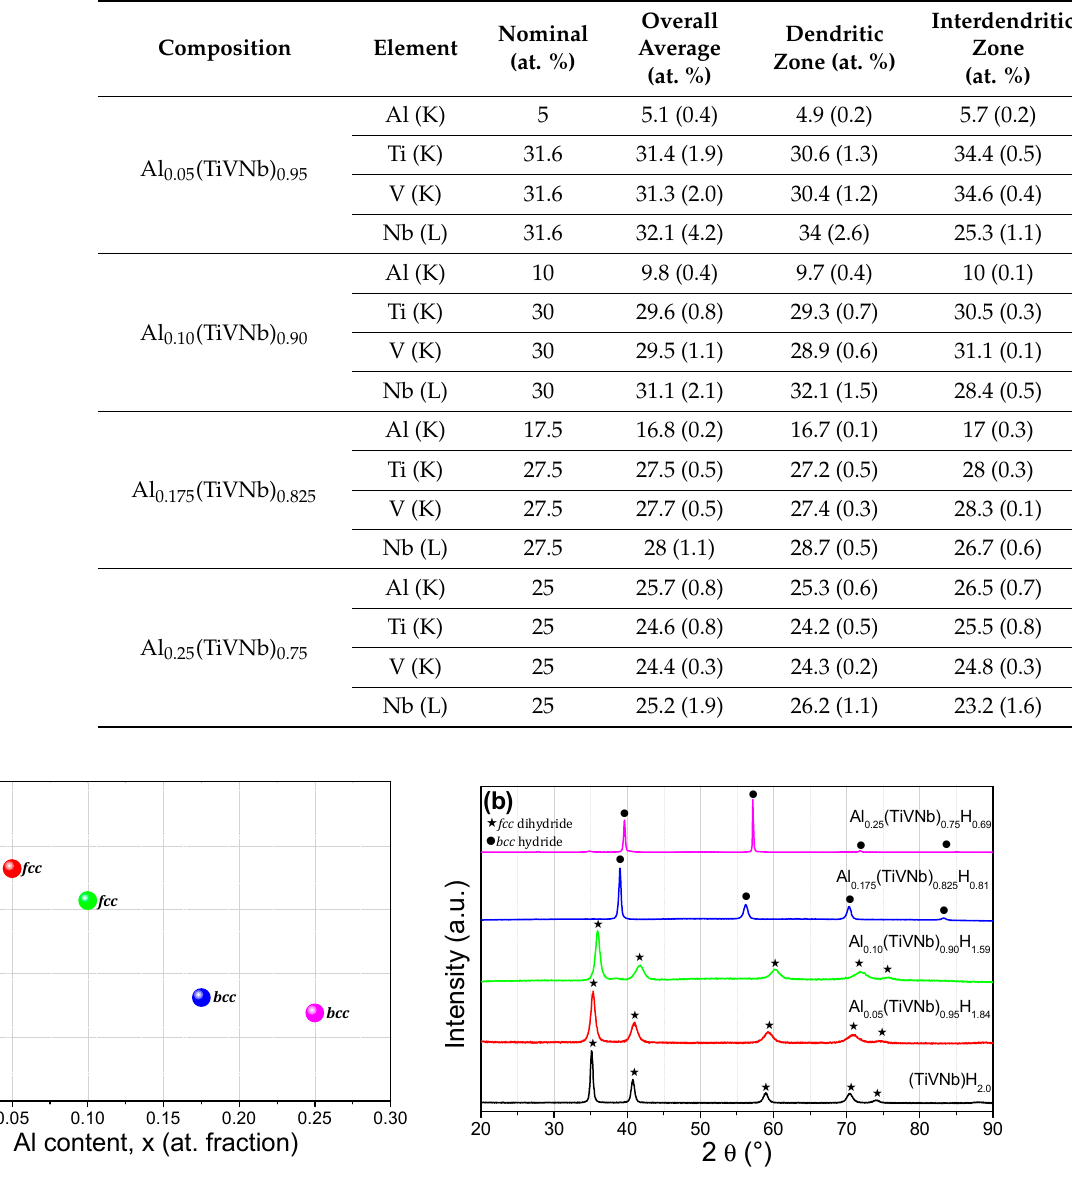
Figure 3. ( a ) Hydrogen storage capacity in terms of H/M as a function of Al content. ( b ) XRD patterns of the Al x (TiVNb) 1 − x hydrides ( λ = 1.5406 Å).